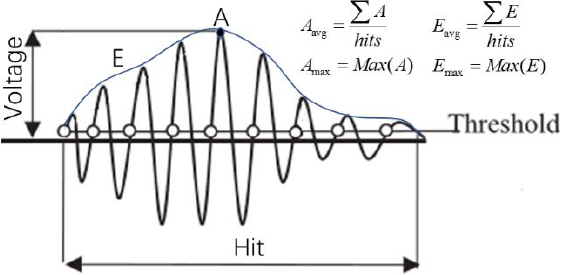
Figure 2. Waveform of AE electrical acoustic emission signals. A represents the amplitude of the signal. E represents the energy of the signal, which is the area enclosed by the blue envelope curve.